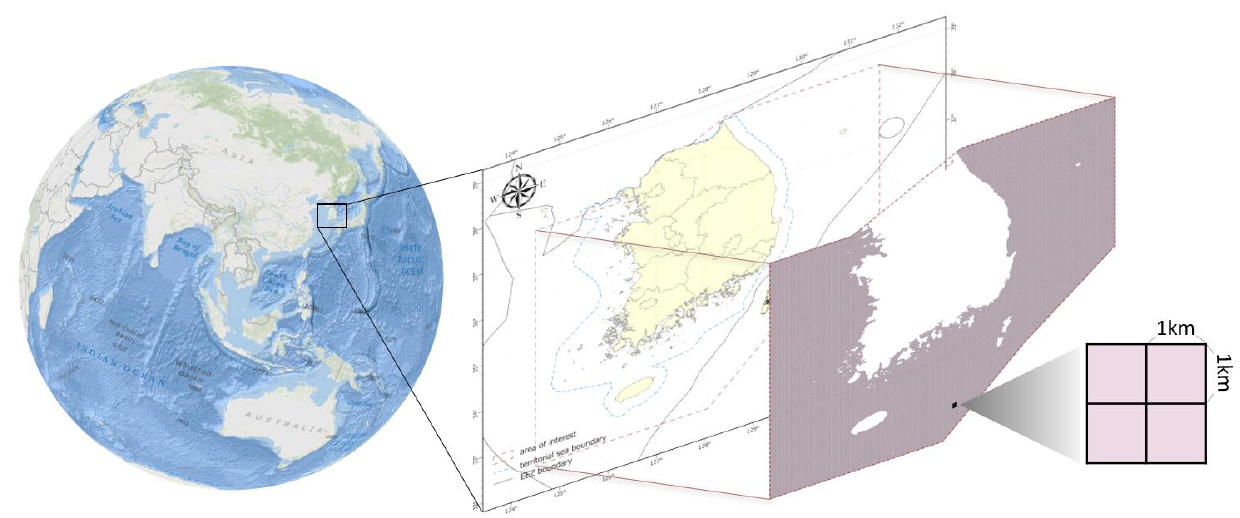
Figure 2. Analysis area covering the coastal waters of Korea and the grid composed of 1 km × 1 km cells. A density analysis requires a grid of certain-sized cells within the analysis area